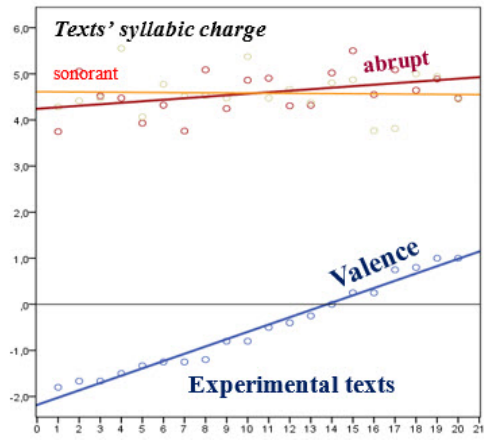
Figure 4. Texts’ Valence and Syllabic Charge of abrupt and sonorant